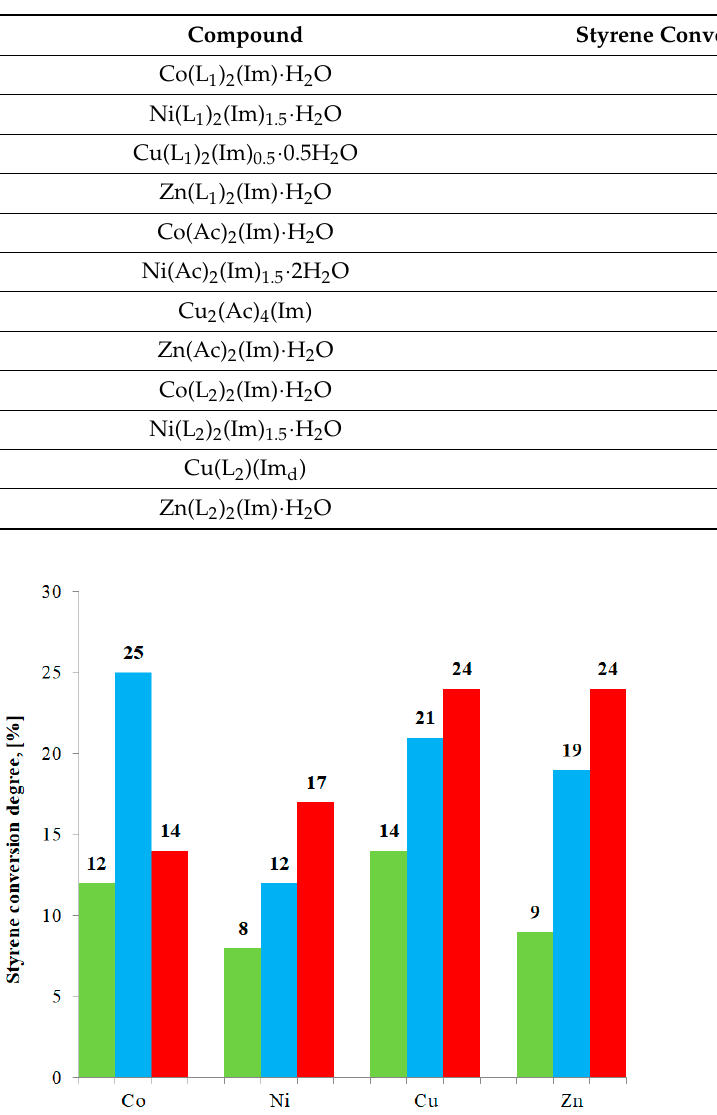
Table 12. Conversion degrees for eight described compounds (M(II) formate or propionate com- plexes with imidazole) and for four previously studied compounds [25] (M(II) acetate complexes with imidazole).